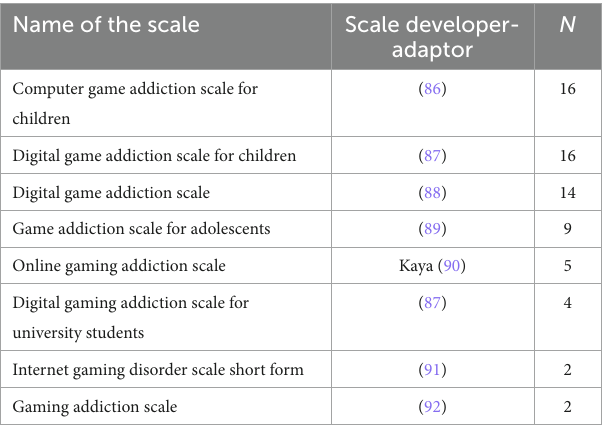
TABLE 2 Scales used in relation to game